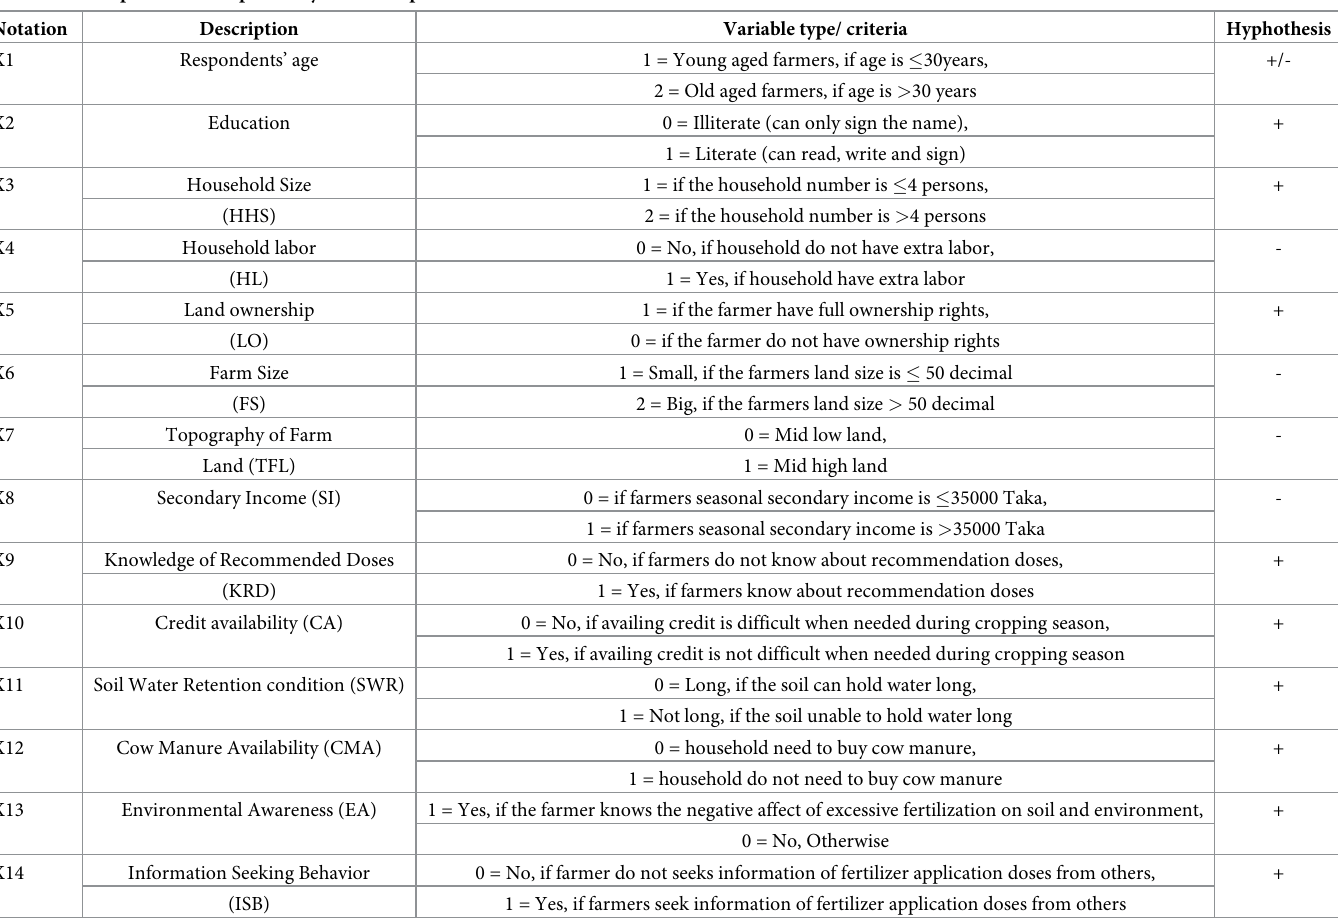
Table 1. Description of the explanatory variables specified in the